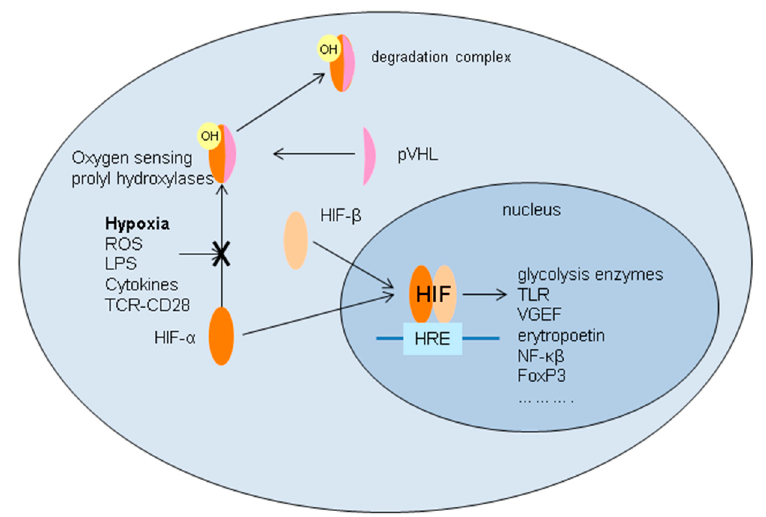
Figure 9. Intracellular stabilisation and activation of hypoxic inducible factor. Under normoxemic conditions, proline on the hypoxic inducible factor (HIF) α (HIF α ) subunit is rapidly hydroxylated by oxygen-sensing prolyl hydroxylase (PHD). This induces a conformational change enabling von Hippel–Lindau tumour suppressor protein (pVHL) to bind with the α -subunit, leading to degradation of the HIF- α subunit. Ischemia (or other signals like lipopolysaccharide (LPS), various cytokines, etc.) will lead to inhibition of the oxygen-dependent PHD, enabling nuclear translocation of the α subunit, binding of the α and β subunit and formation of HIF. In the nucleus, HIF binds with the hypoxia response promotor element (HRE) leading to the transcription of various genes. VGEF: vascular endothelial growth